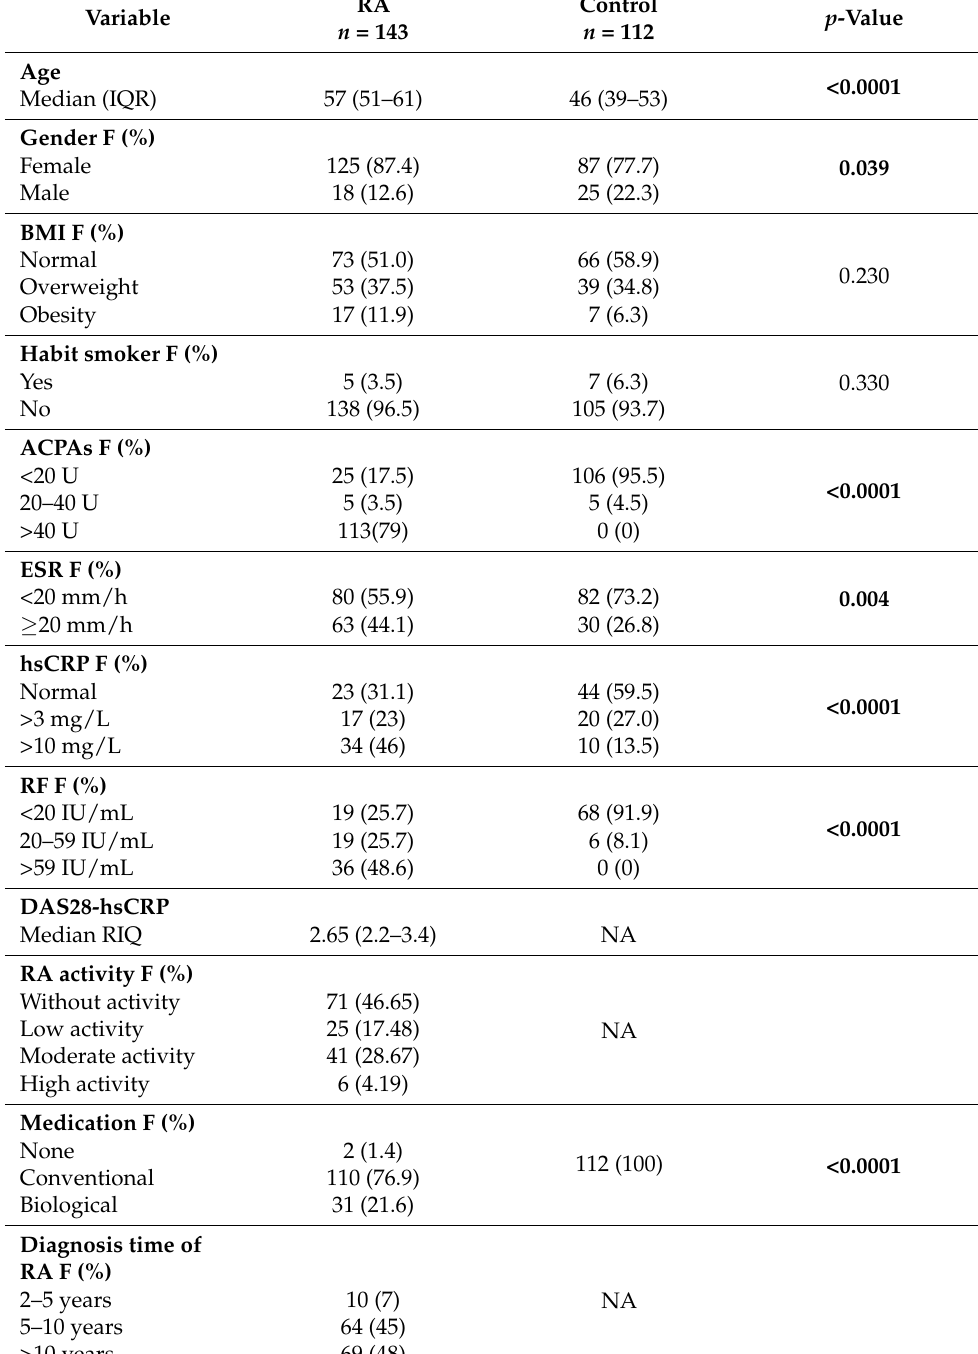
Table 1. Description of socio-demographic and clinical variables and markers associated with